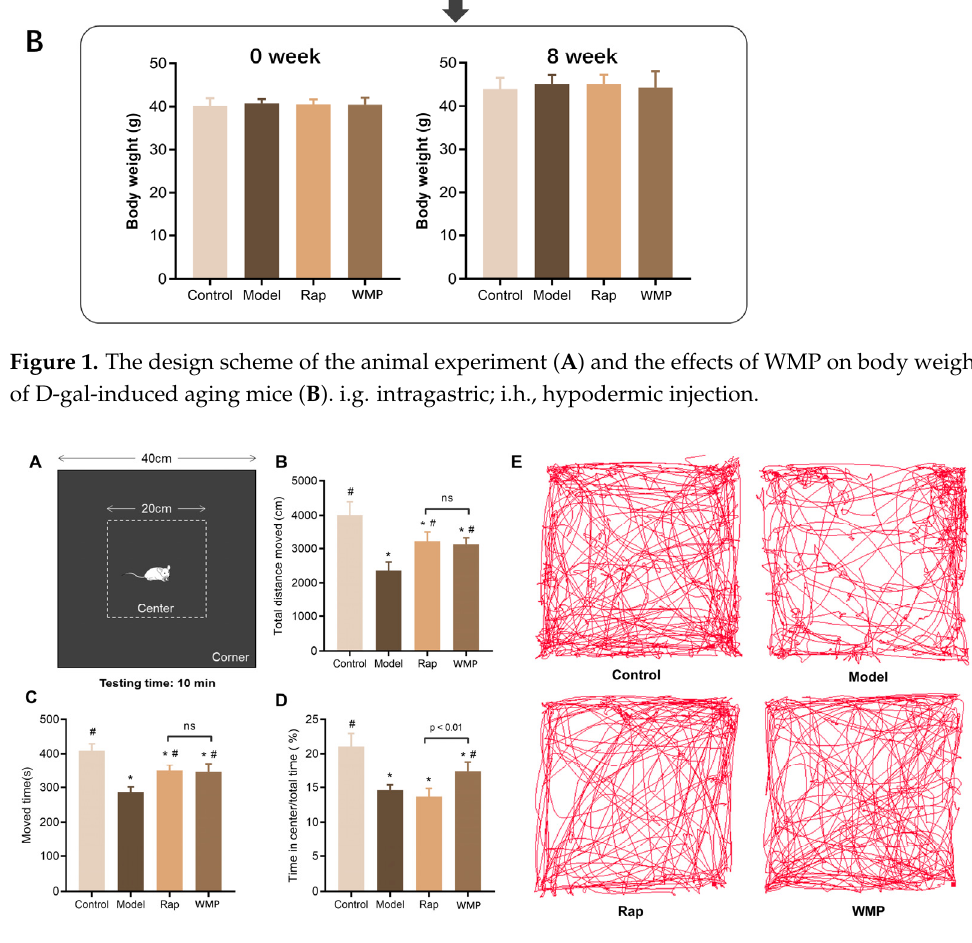
Figure 1. The design scheme of the animal experiment ( A ) and the effects of WMP on body weights of D-gal-induced aging mice ( B ).i.g. intragastric; i.h., hypodermic injection.